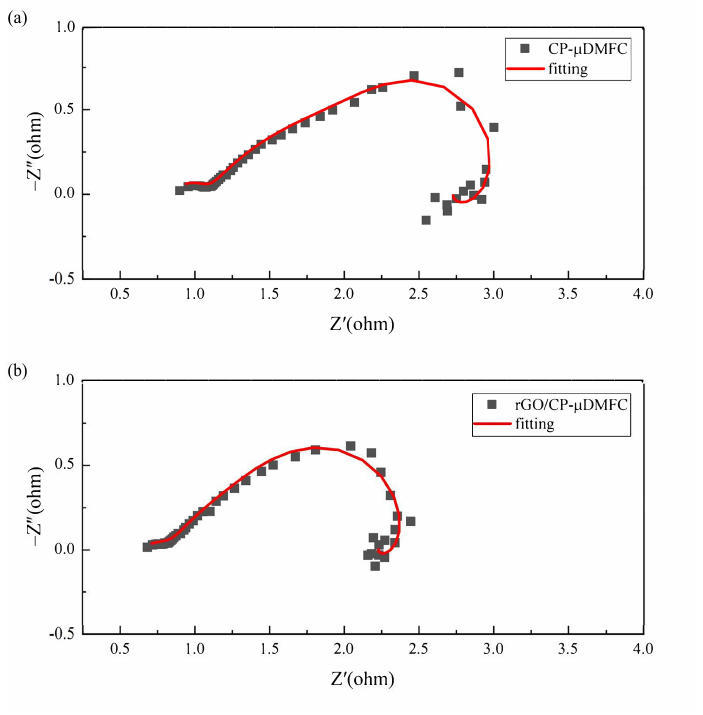
Figure 8. EIS fitting examples at 343 K, 2 mol/L, and 80 mA/cm 2 : ( a ) CP- µ DMFC; ( b ) rGO/CP- µ DMFC. The identified impedance parameters are listed in Table 3. Table 3. Parameter identification